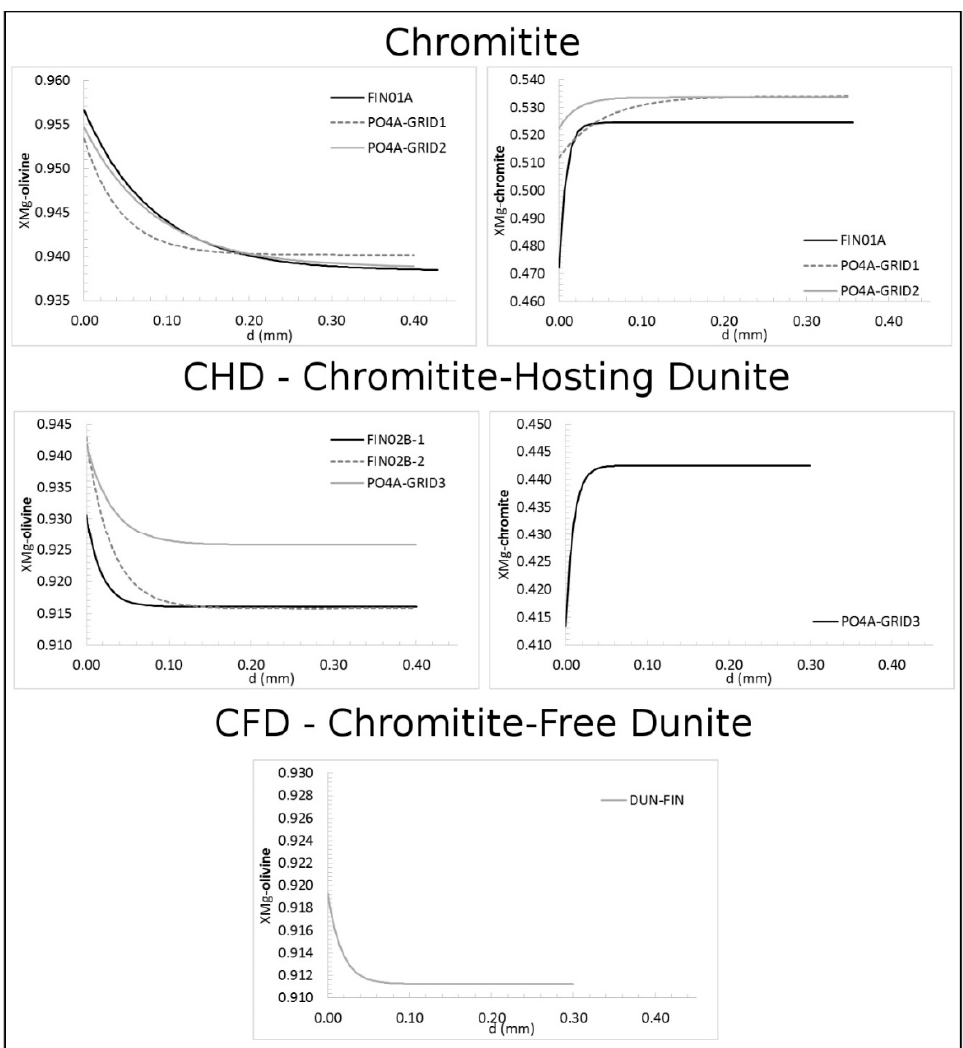
Figure 5. Diffusivity curves determined for olivines and chromites in three host rocks through OriginLab software; d (mm): distance from the grain boundary.